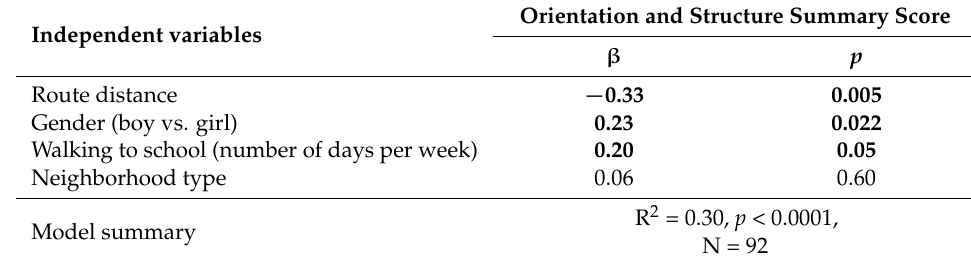
Table 5. Multivariable linear regression models to predict the orientation and structure summary